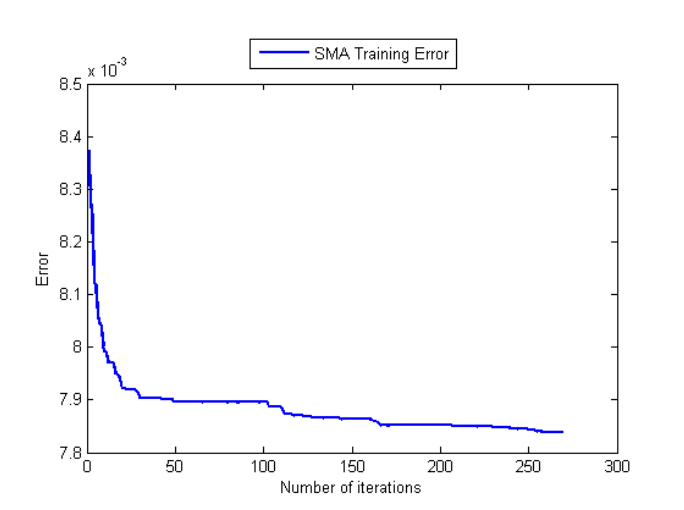
Figure 10. Curves of actual ratings and predicted ratings of GA.